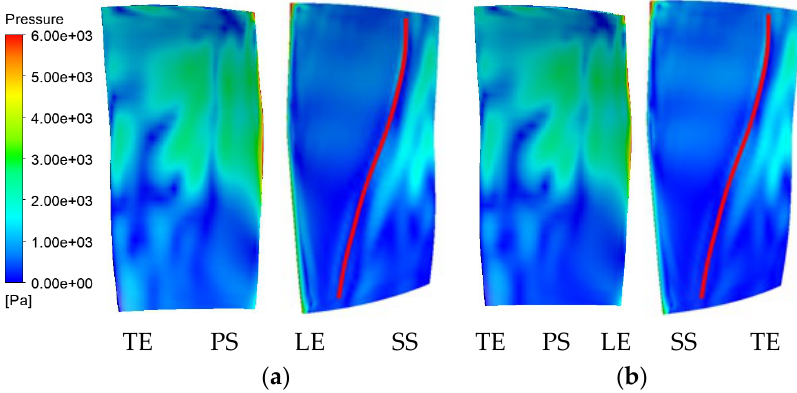
Figure 20. 54 EO amplitude of static pressure on the surface of R1 rotor blade (red line is shock wave). ( a ) C# ( b ) M#.